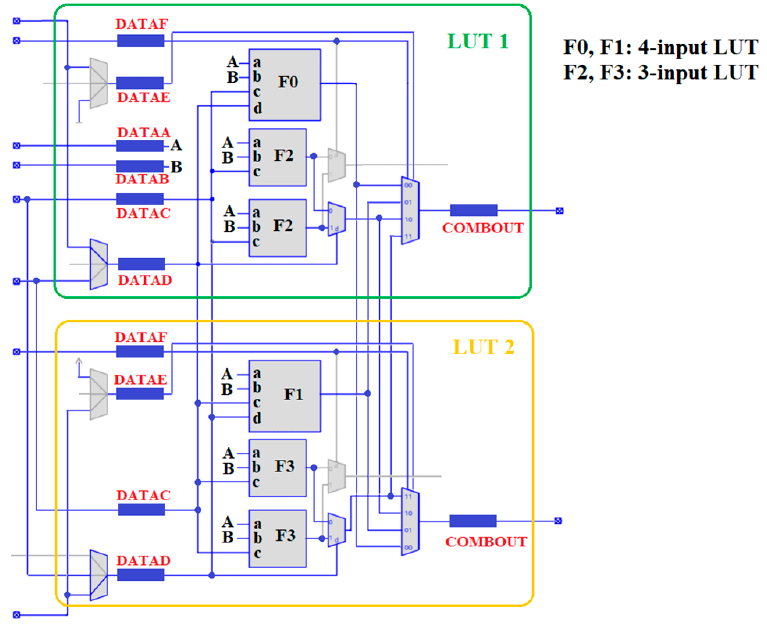
Figure 7. Configuration of two LUTs inside an ALM of Cyclone V.